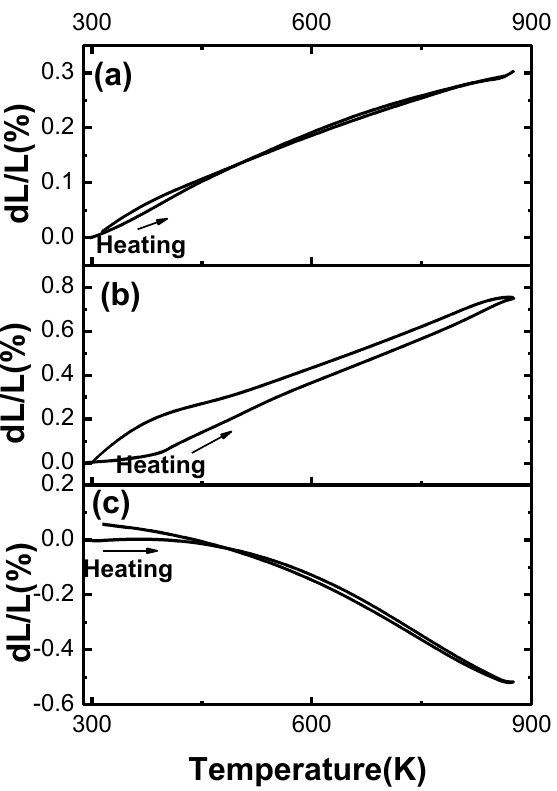
Figure 3. Relative length change ( dL / L ) with the temperature of the samples: ( a ) SmMnO 3 , ( b ) SrMnO 3 , and ( c ) Sm 0.85 Sr 0.15 MnO 3- δ .